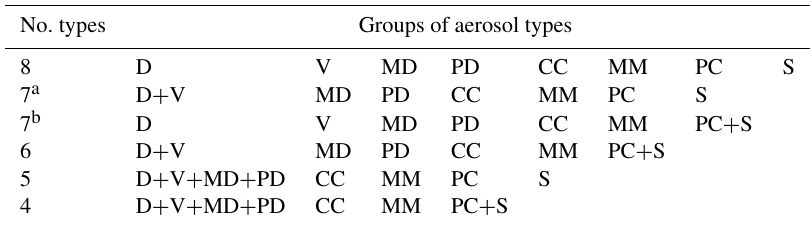
Table 3. Aerosol types that constitute the classes investigated. CC stands for clean continental, PC stands for polluted continental, D stands for dust, MD stands for mixed dust, PD stands for polluted dust, MM stands for mixed marine, S stands for smoke, and V stands for volcanic